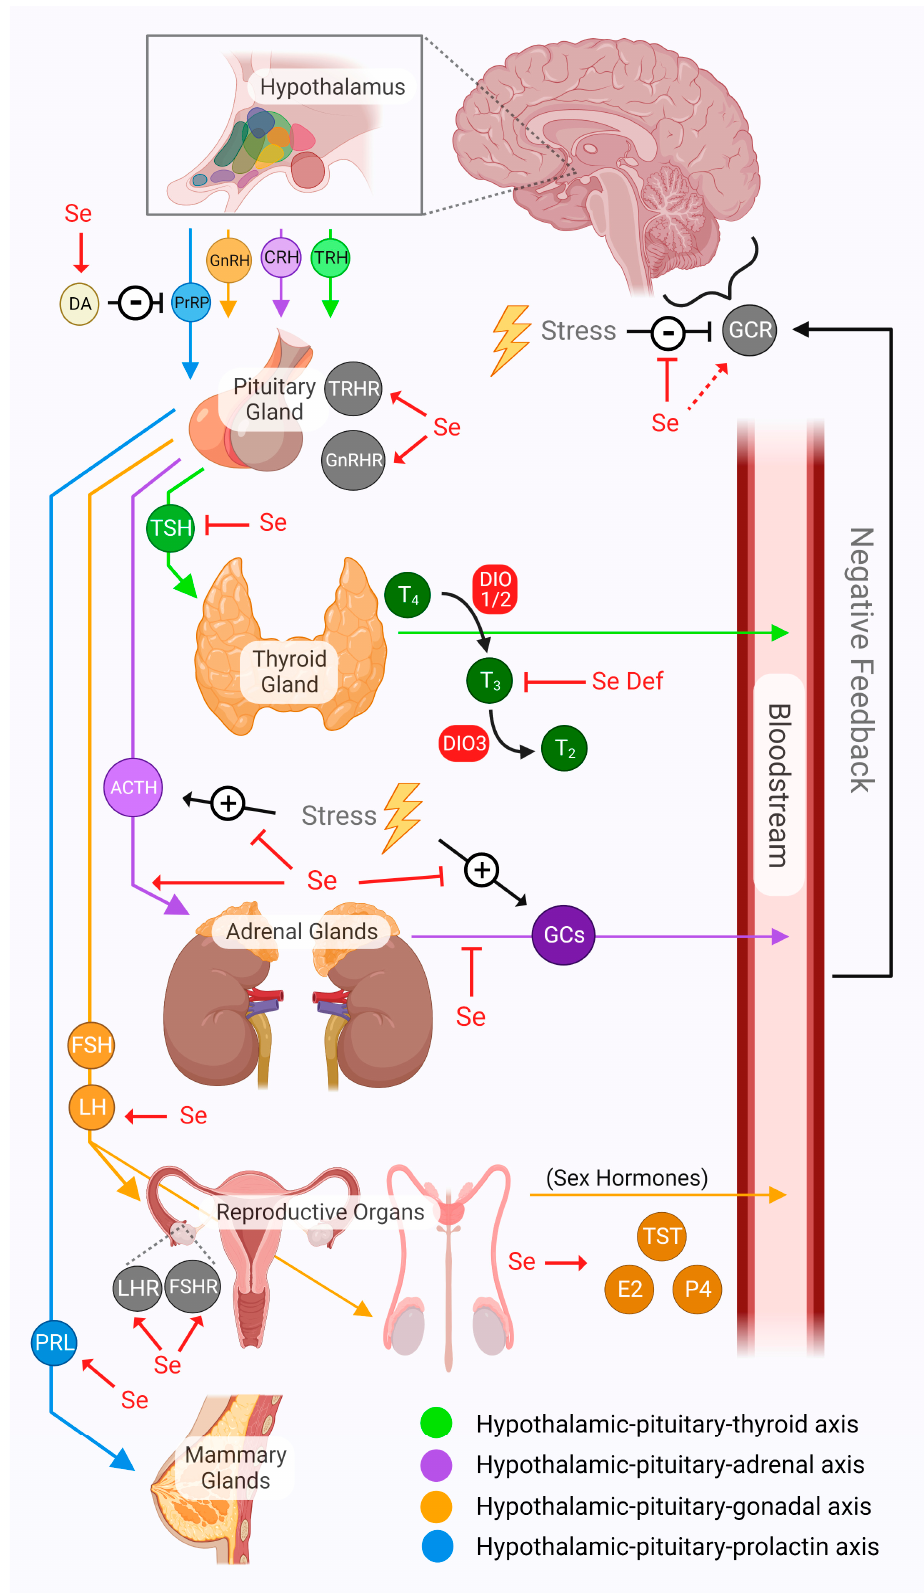
Figure 2. Hypothalamic axes of communication and the various effects of selenium. The hypothalamus sends regulatory signals throughout the body by controlling the release of hormones from the anterior pituitary gland. Selenium (Se) has shown an ability to upregulate the thyrotropin- releasing hormone receptor (THR) and gonadotropin-releasing hormone receptor (GnRHR) in the pituitary gland. Along the hypothalamic–pituitary–thyroid (HPT) axis, selenium has shown a capacity to limit thyroid-stimulating hormone (TSH) from the pituitary gland and is intimately involved in thyroid hormone metabolism, as it is used to synthesize the iodothyronine deiodinase (DIO) sub-family of selenoproteins. Evidence from multiple lines of investigation suggest that selenium plays a role in normalizing the HP–adrenal axis under conditions of elevated stress, through mechanisms involving the limiting of adrenocorticotropic hormone (ACTH) secretion from the pituitary and glucocorticoid (GC) secretion from the adrenal gland. Additionally, the negative feedback loop of the HPA axis is supported, by helping the brain maintain GC receptor (GCR) expression levels, which are typically downregulated by chronic over-activation. Selenium seems to promote the secretion of luteinizing hormone (LH) from the pituitary gland and the expression of the receptors for LH (LHR) and follicle-stimulating hormone (FSHR) in the ovaries. Selenium is also important for maintaining sufficient production of sex hormones, including testosterone (TST),